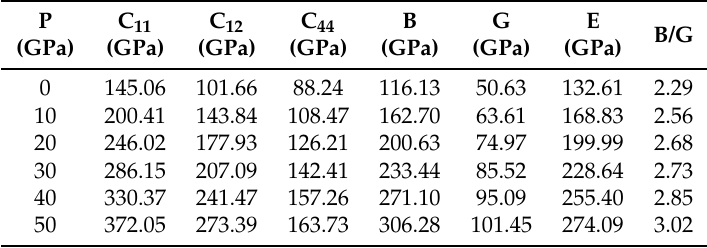
Table 1. The elastic constants C ij , bulk modulus B, shear modulus G, Young’s modulus E and Pugh’s ratio B/G of Ti 2 NiIn compound under different